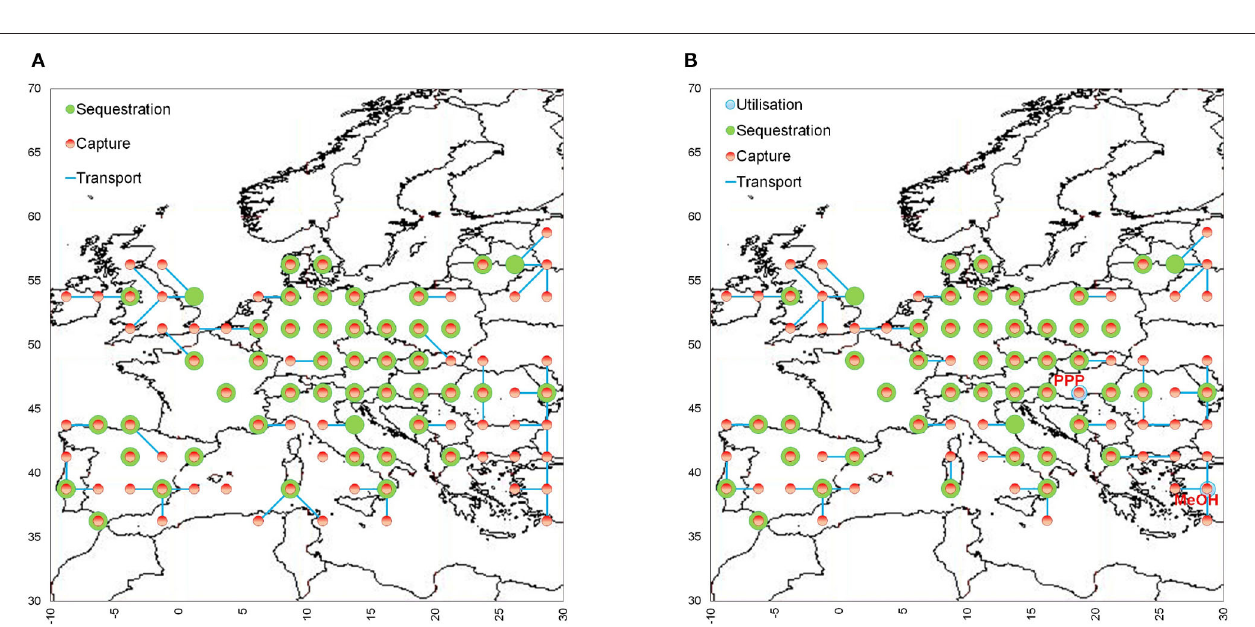
FIGURE 3 | Comparison between Scenario 0 and Scenario A in terms of: (A) relative variations in total cost ( TC ) and exploitation of geological sequestration ( S ); and (B) effective net CO